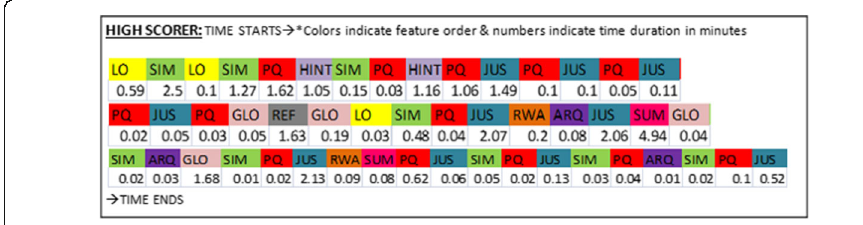
Fig. 12 Learning path of students from cycle 2